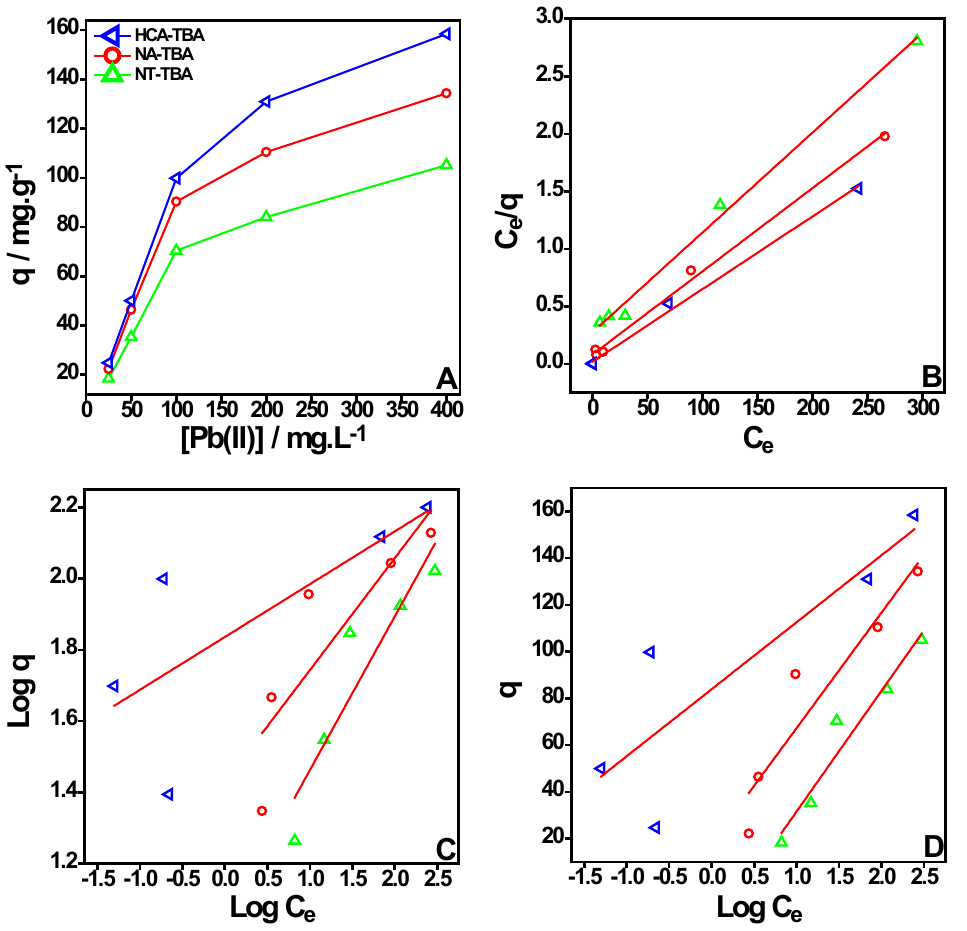
Figure 3: Effect of initial Pb(II) ions concentration on Pb(II) uptake by original and chemically pretreated TBP (A), Langmuir isotherm plot (B), Freundlich isotherms plot (C) and Temkin plot (D) for Pb(II) biosorption by original and chemically pretreated